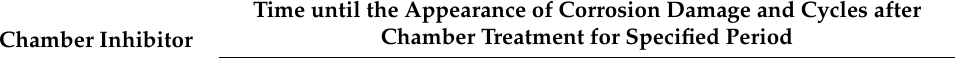
Table 2. Protective aftereffect of adsorption films formed on copper in CIN vapors at 100 ◦ C and at various τ CT in the salt fog